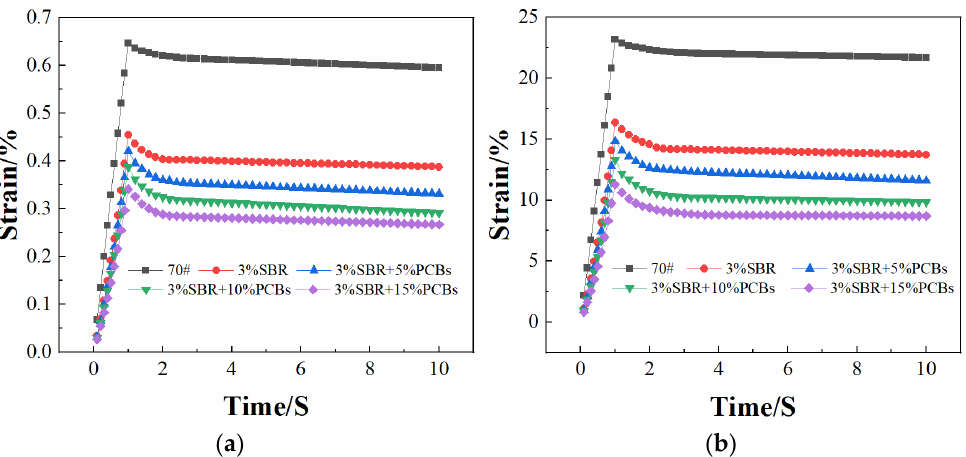
Figure 6. Strain under different stress conditions in Multiple Stress Creep and Recovery (MSCR) test: ( a ) 0.1 kPa; ( b ) 3.2 kPa. Table 8. Results of irrecoverable compliance at stress levels of 0.1 kPa and 3.2 kPa.